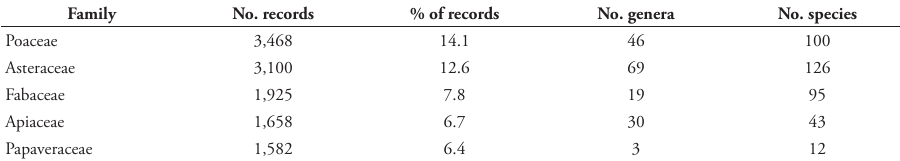
Table 1. The five most represented families in the “Segetal flora of Italy” dataset: number of records, percentage of records, number of genera and number of species are reported for each family.